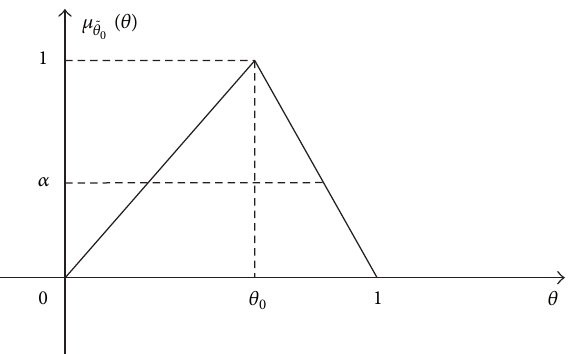
Figure 2: The definition of triangular fuzzy